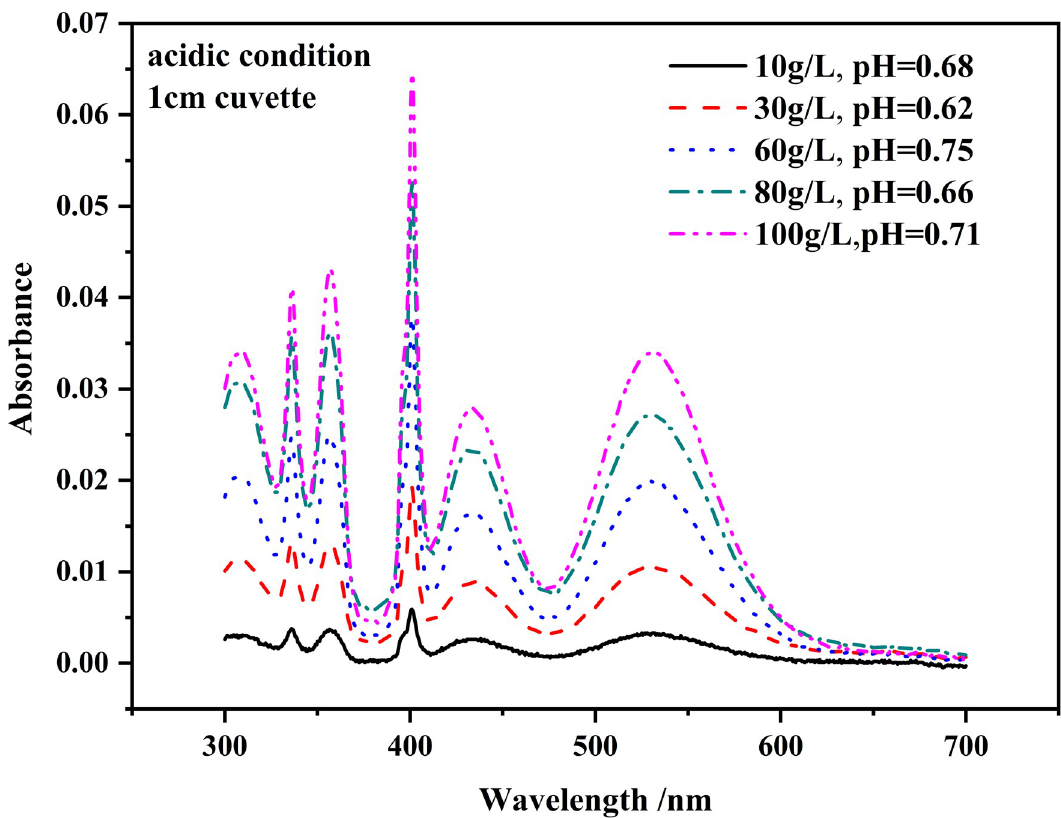
Fig 3. Spectra of MnSO 4 solutions with different concentrations and low